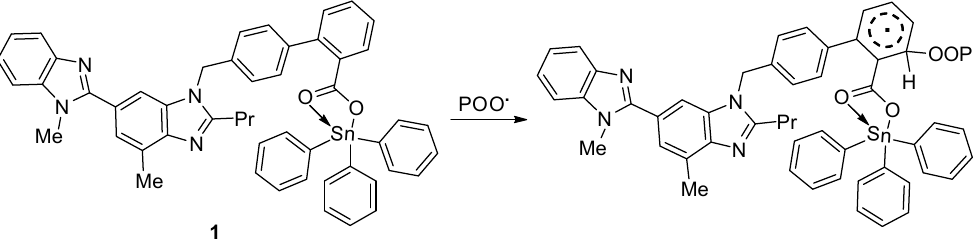
Figure 16. Organotin 1 acts as a radical scavenger.